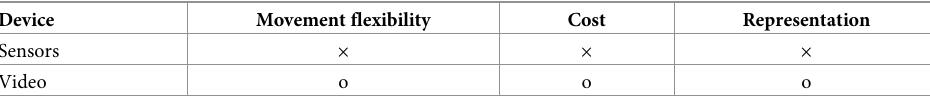
Table 1. Comparison of sensors and